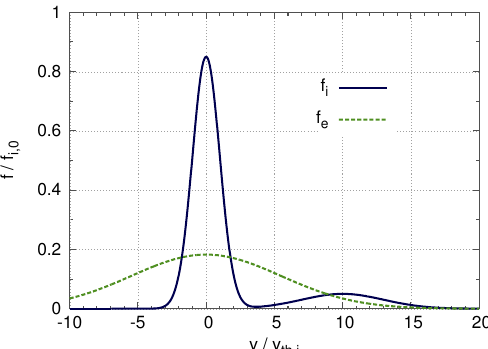
Figure 10. Velocity distribution of ions (solid curve) and electrons (dotted curve) in a two-species plasma with a population of supra-thermal particles and equal bulk ion and electron temperatures. The ion/electron mass ratio is reduced to 30 for the sake of readability of the